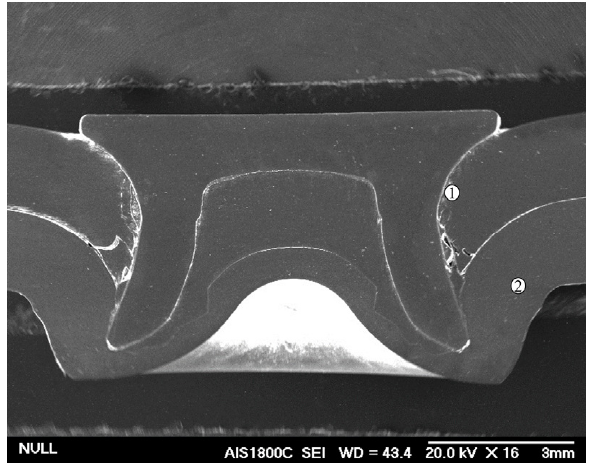
Figure 6. Observed the cross-section of the SPR joint by SEM and measured points of the residual stress.